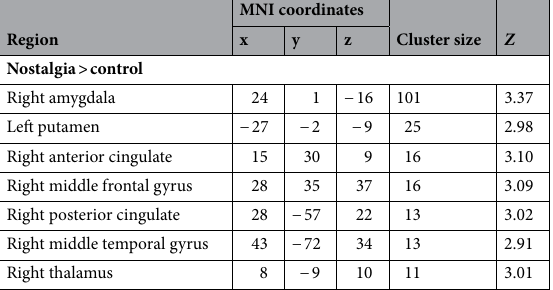
Table 2. Brain regions exhibiting significant activation during the word relationship task (death-related words vs. neutral words) in the nostalgia and control conditions. Death-related words > Neutral words; p < 0.005 (uncorrected); min. cluster =